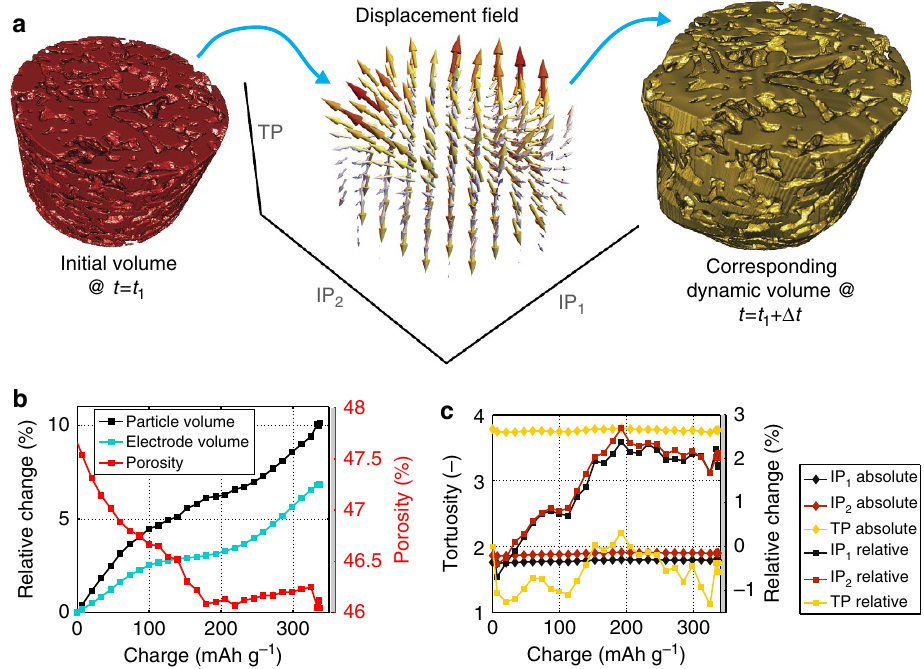
Figure 4 | Microstructure analysis on dynamic volumes. ( a ) Left: sketch of a cylindrically-shaped observation volume within the bottom electrode in the initial time step. Middle: vector field representing the displacements within this volume between the first and the last time steps. The IP and TP vector field components have been rescaled for better visibility. Right: dynamic volume in the last time step resulting from warping the initial red volume with the displacement field. ( b ) Electrode volume, particle volume and porosity as a function of charge as determined from the dynamic volumes. ( c ) Tortuosities along the two IP and the TP direction as a function of specific charge. The right axis refers to their change relative to the initial